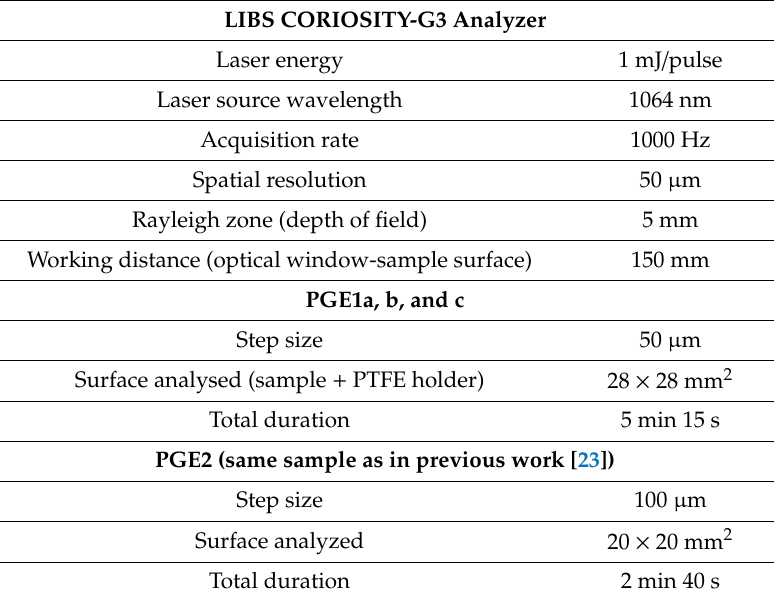
Table 3. Principal LIBS analysis parameters used for the samples PGE1a, b, and c, and